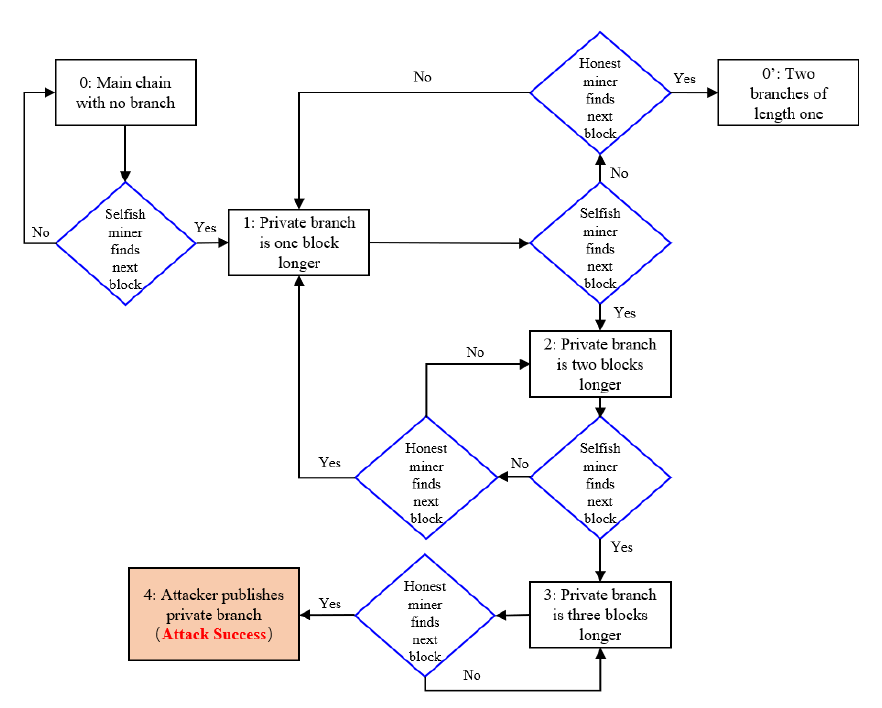
Figure 1. Flowchart of a successful selfish mining